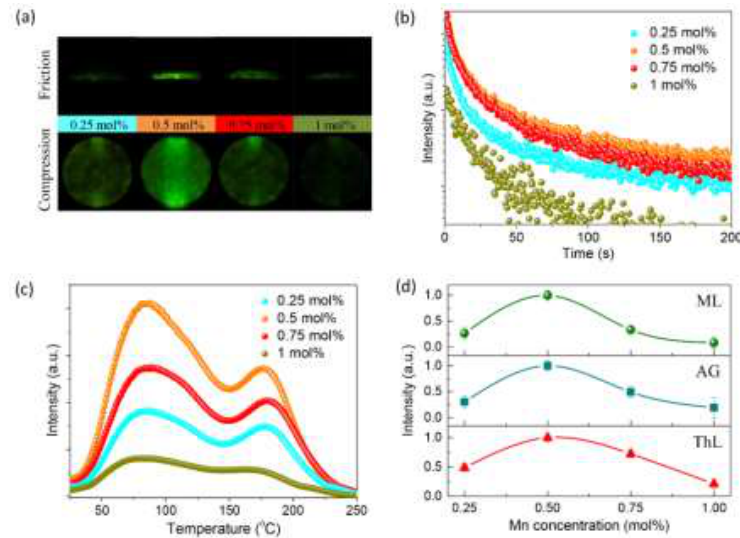
Figure 2. Characterization of ML, AG, and thermoluminescence (ThL) in Li 2 MgGeO 4 :Mn 2+ with different Mn 2+ concentrations. ( a ) Optical images of ML induced by friction (upper) and compression (bottom). ( b ) AG curves. ( d ) ThL curves. ( c ) Dependence of ML intensity, AG intensity, and integrated ThL intensity on Mn 2+ concentration.